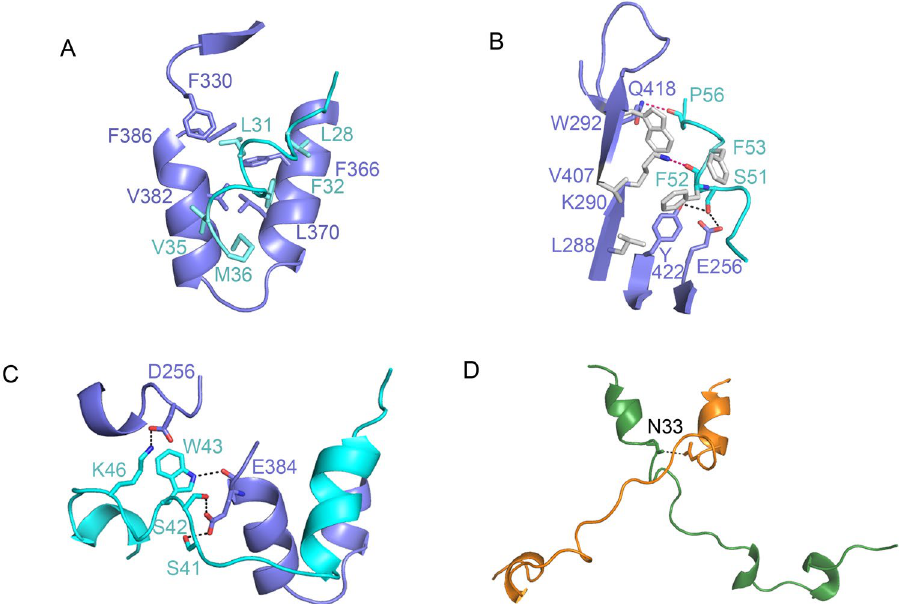
Figure 2. Interactions between residues at the TAZ-TEAD interface. ( A ) The interface between TAZ helix α 1 and TEAD reveals a hydrophobic patch of TAZ helix α 1 (cyan) interacting with a hydrophobic groove formed by helix α 3, α 4 and β 6- β 7 loop of TEAD (purple). The side chains of residues involved in the interactions are shown in stick representation. ( B ) The second interface, between TAZ helix α 2 and TEAD, consists of hydrophobic (grey), Van der Waals’ (red dash) and hydrogen bond (black dash) interactions. ( C ) In the first binding mode, where one TAZ molecule binds to one TEAD molecule, the residues in the loop region of TAZ form hydrogen bonds with TEAD. ( D ) In the second binding mode, where one TAZ molecule binds two TEAD molecules, the loops of two TAZ molecules (green and orange) cross each other and a unique hydrogen bond is formed between the TAZ